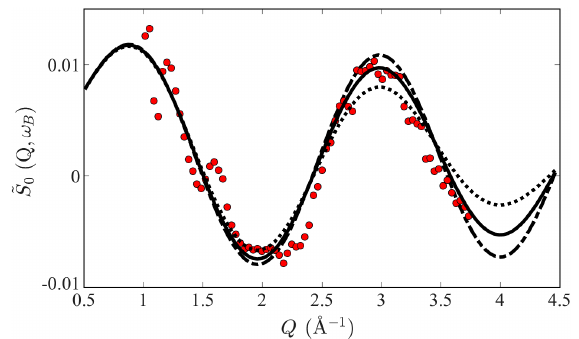
˜ S ð Q; ω for ω of 24 (cid:2) 2 × 10 12 rad = s. b Þ(cid:3) b 0 . 4 Å. Dotted line: Fit for b ¼ 0 . 2 Å. The fit b ¼